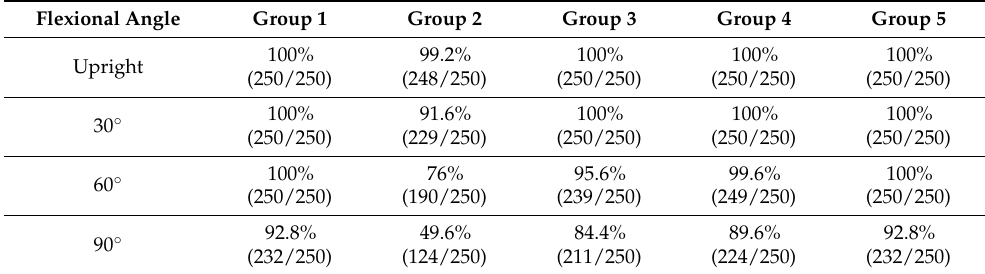
Table 1. Success rate (Number of successful simulations/number of simulations performed in each group) in various trunk flexion tasks. Each group contains 250 models, and thus, 250 simulations were performed in each group. When the static optimization could find an optimal solution, it was treated as an unsuccessful simulation. Flexional Angle Group 1 Group 2 Group 3 Group 4 Group 5 100% Upright (250/250)